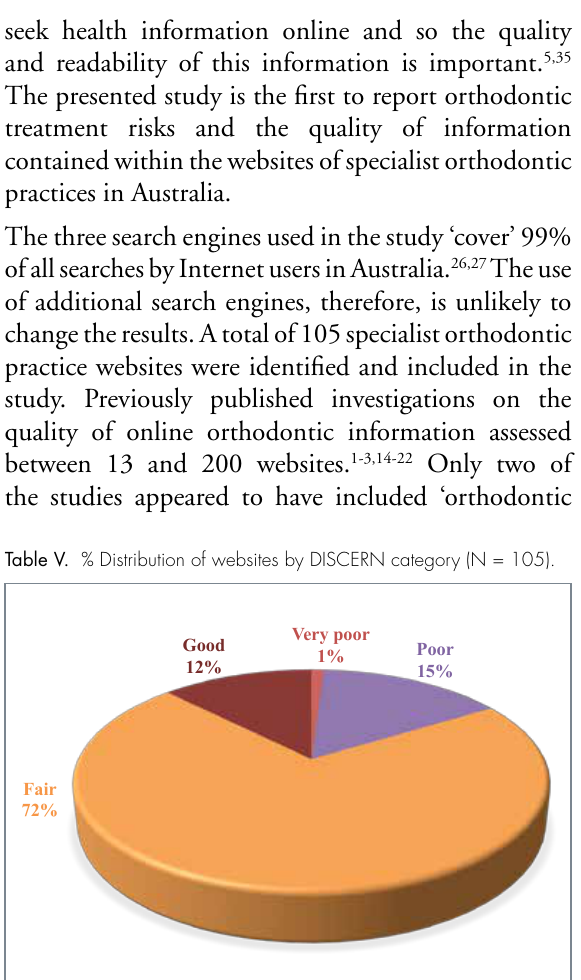
Table VI . Distribution of evaluated websites by FRE category (N = 105).